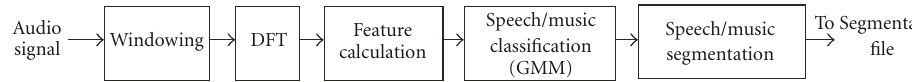
Figure 5: Block scheme of the proposed speech/music segmentation and classification framework.